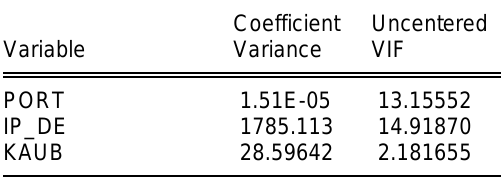
Variance Inflation